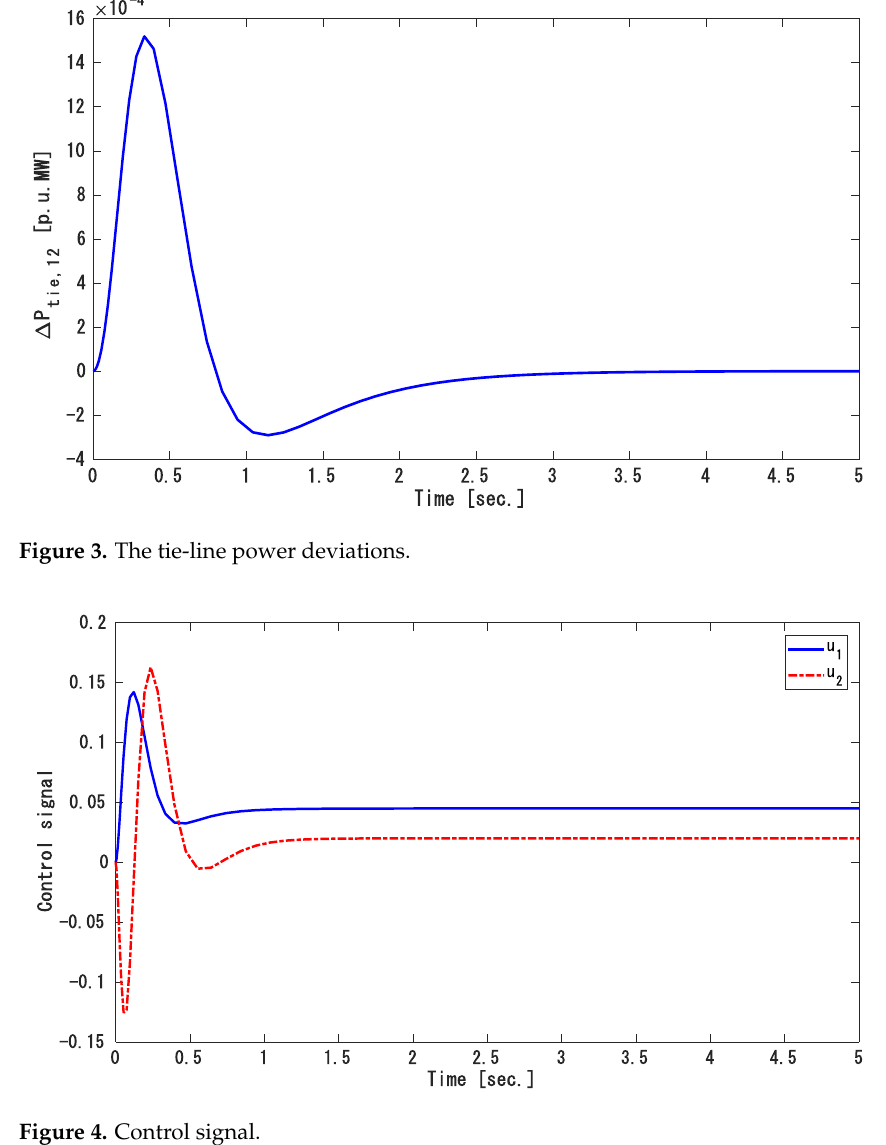
Figure 4. Control